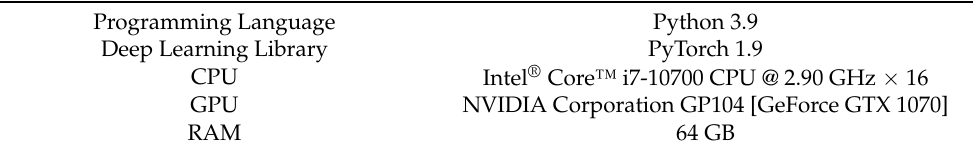
Table 1. The implementation details.